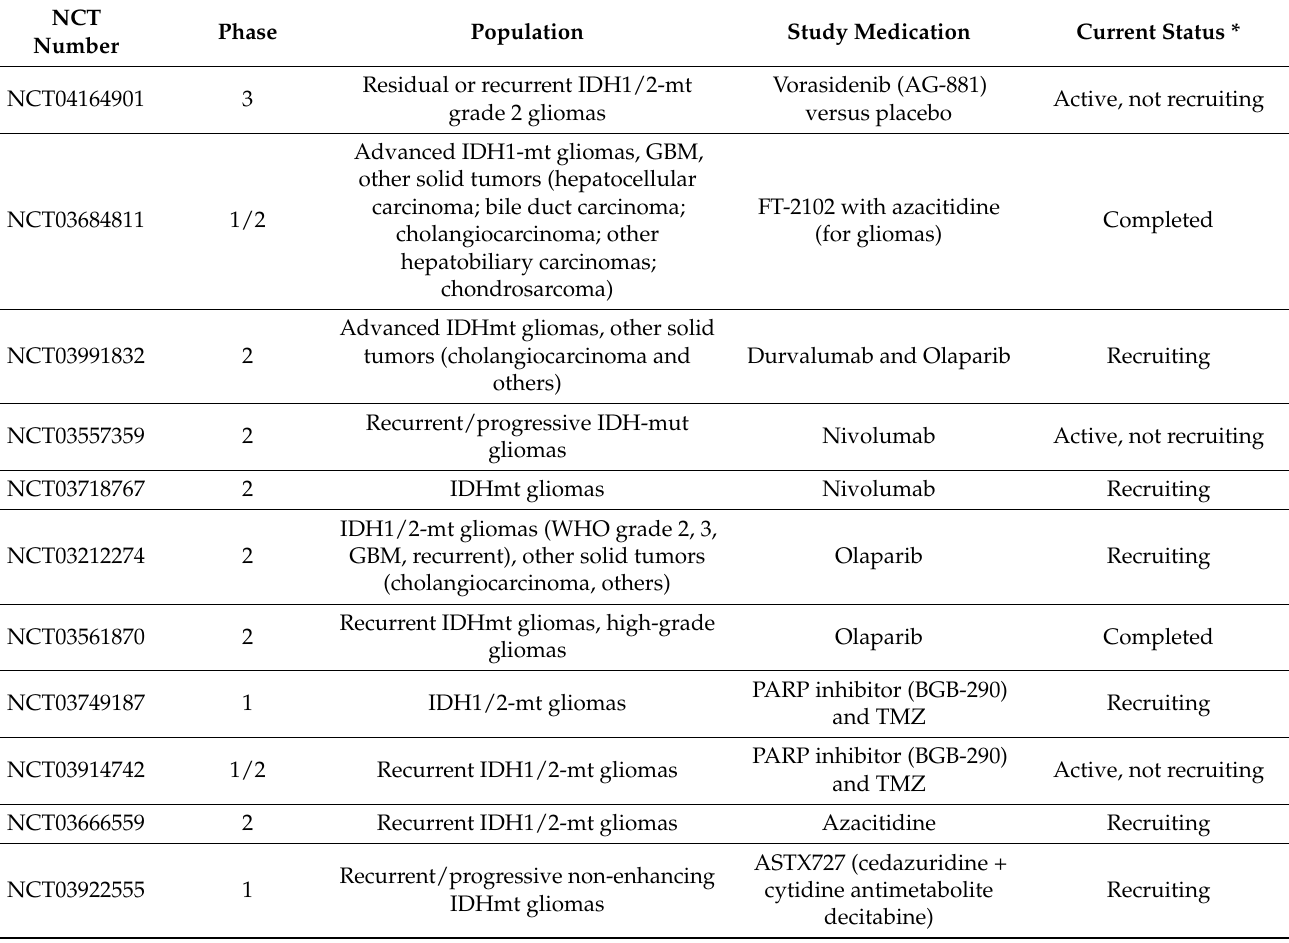
Table 2. Ongoing clinical trials in IDH-mutant LGGs. Adapted under Creative Commons Attribution 4.0 International (CC BY 4.) License from